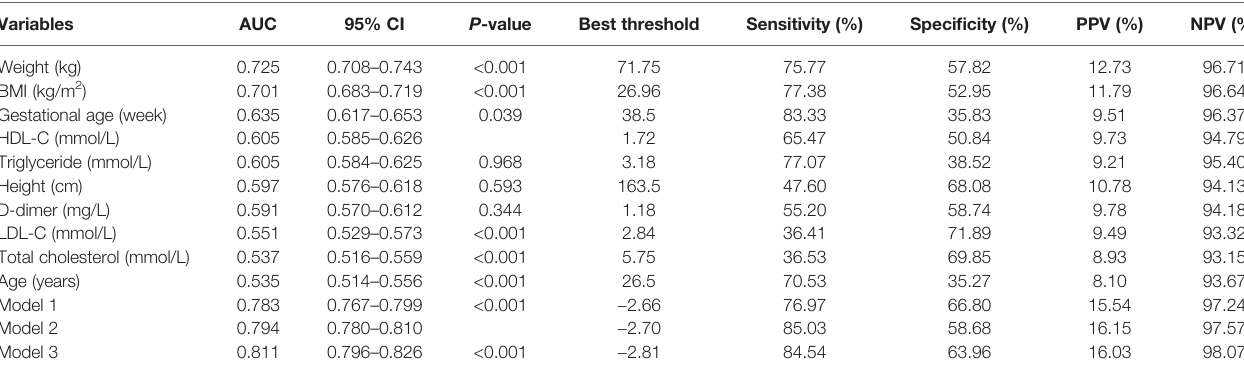
TABLE 5 | Accuracy of different models and variables in late pregnancy to predict macrosomia. Variables